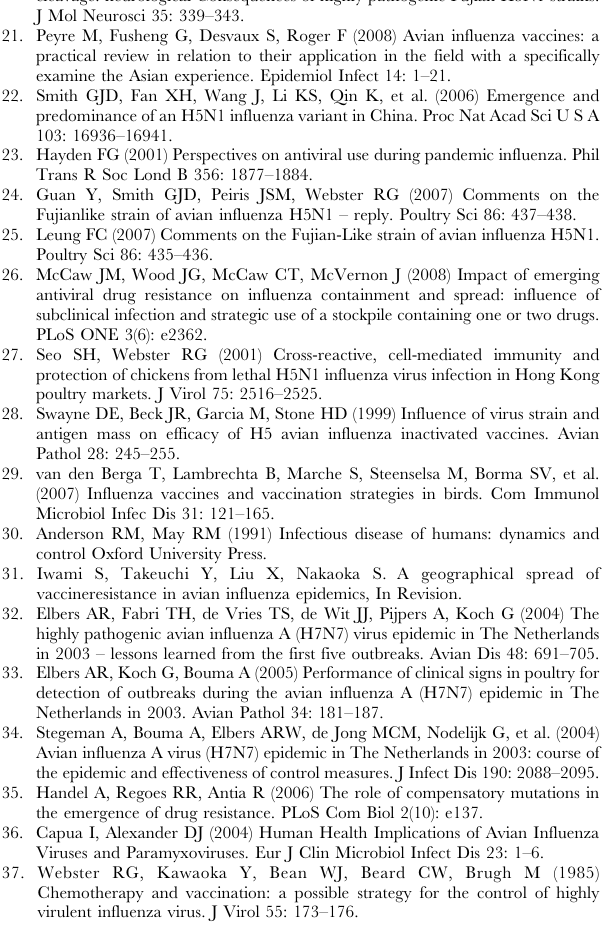
Figure S2 Found at: doi:10.1371/journal.pone.0004915.s002 (0.42 MB EPS) Figure S3 Found at: doi:10.1371/journal.pone.0004915.s003 (0.44 MB EPS) Figure S4 Found at: doi:10.1371/journal.pone.0004915.s004 (0.47 MB EPS) Figure S5 Found at: doi:10.1371/journal.pone.0004915.s005 (0.43 MB EPS) Figure S6 Found at: doi:10.1371/journal.pone.0004915.s006 (1.01 MB EPS) Figure S7 Found at: doi:10.1371/journal.pone.0004915.s007 (1.02 MB EPS) Figure S8 Found at: doi:10.1371/journal.pone.0004915.s008 (1.83 MB EPS)